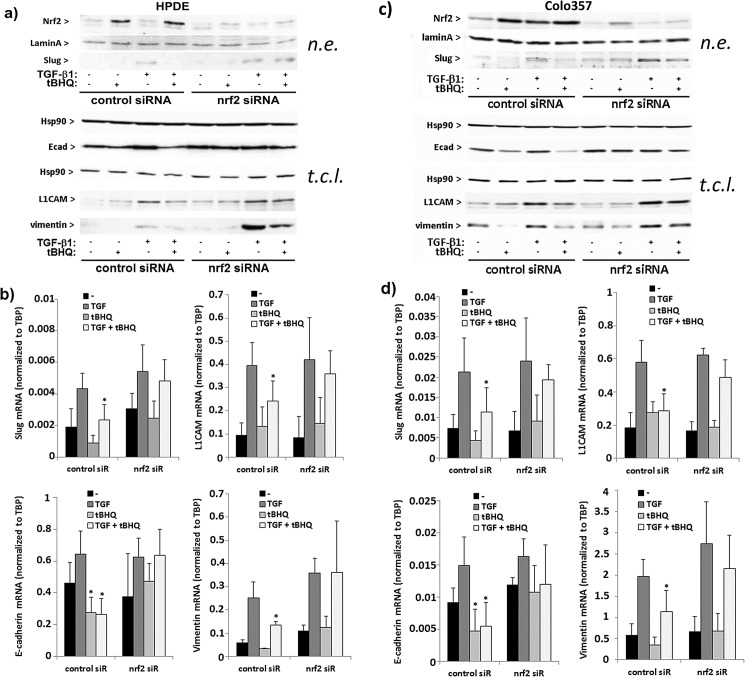
Nrf2 dependency of the tBHQ effects on EMT marker expression in premalignant HPDE and malignant Colo357 pancreatic duct cells.HPDE or Colo357 cells incubated with Nrf2 or control siRNA for 48h were further treated for 24h with tBHQ or TGF-β1, either alone or in combination, or were left untreated. Then, either nuclear extracts (n.e.) or total cell lysates (t.c.l.) were analysed by westernblot (A,C), or RNA samples were analysed by real-time PCR (B,D) for the expression of Slug, L1CAM, E-cadherin or vimentin. Lamin-A/C and Hsp90 were used as loading controls for the westernblots of nuclear extracts and total cell lysates, respectively (A,C), and for normalization of Slug, L1CAM, E-cadherin and vimentin mRNA level TBP was analysed in parallel (B,D). Either a representative result from three independent experiments (A,C) or the mean ± SD from six independent experiments (B,D) are shown, *p<0.05 (+tBHQ versus–tBHQ). (A,C) a densitometric band intensity evaluation is provided in Figs. A and B in S4 File.